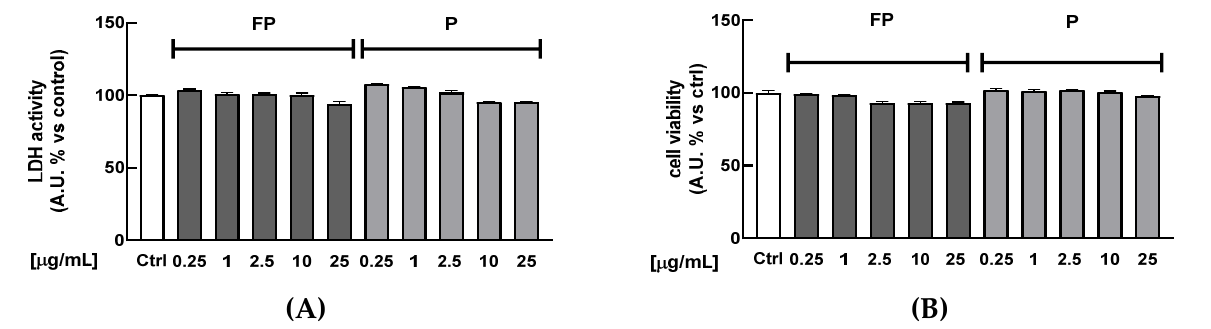
Figure 1 . HUVECs were treated with fermented Pushgay (FP) or Pushgay (P) berries solutions for 24 h (concentration range: 0.25–25 µg/mL). ( A ) Cell viability was assessed by measuring red dye production at 490 nm ( B ) Cytotoxicity was quantified by spectrophotometrically measuring LDH released in cell medium. Ctrl (control, untreated cells); FP (cells treated with fermented Pushgay solution); P (cells treated with Pushgay solution).